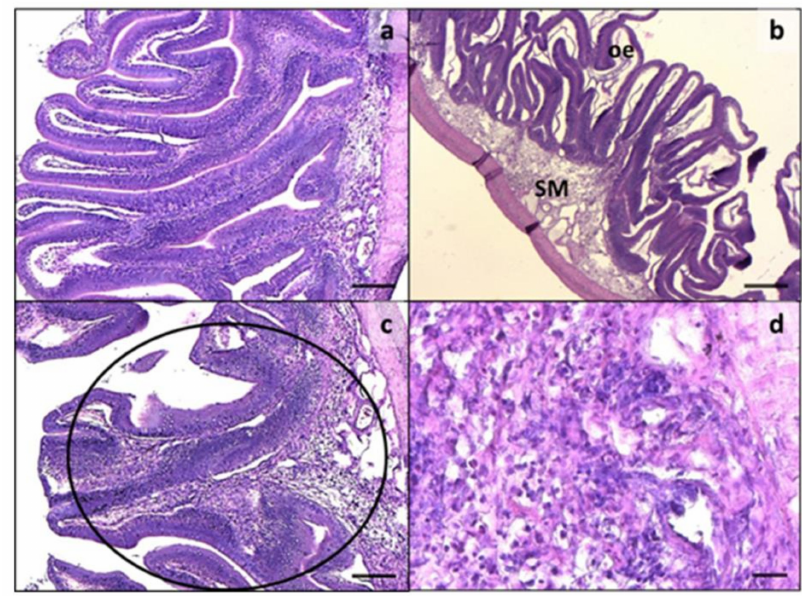
Figure 2. Distal intestine. ( a ) Normal histology from CF; ( b ) histological architecture alterations, including diffuse oedema (oe) and submucosa thickening in CV; ( c ) detail of fold fusion (circle) in CV distal intestine; ( d ) high magnification showing lymphocyte infiltration in CV submucosa. SM: submucosa. Scale: a , c = 100 µ m; b = 200 µ m; d = 20 µ